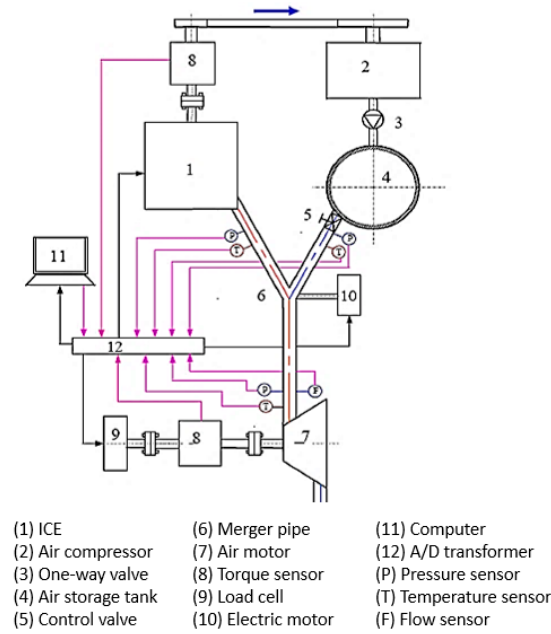
Figure 1. The framework of our hybrid pneumatic power system (HPPS).